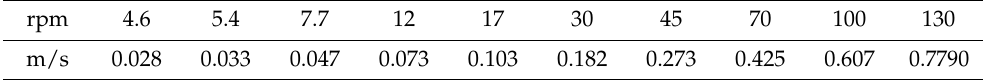
Table 2. Sliding speeds that were applied for the tests in the angular (rpm) and linear (m/s) speeds.